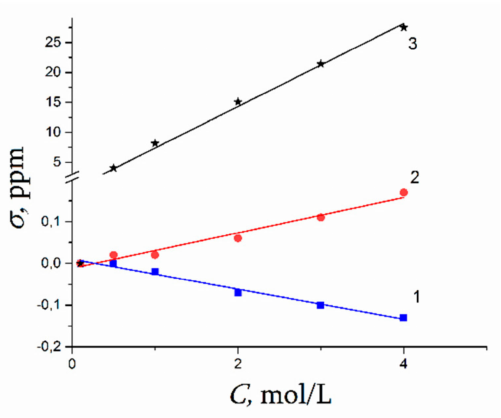
Figure 45. 7 Li (1), 23 Na (2), 133 Cs (3) nuclear NMR chemical shift concentration dependences in lithium, sodium, cesium chloride aqueous solutions